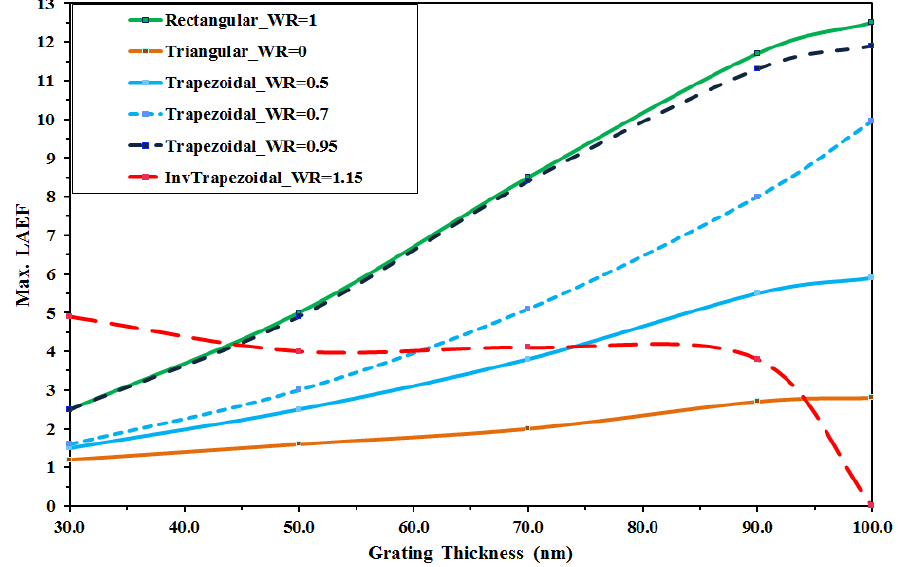
Figure 8. The possible maximum LAEF achieved in different nano-gratings thickness [76].